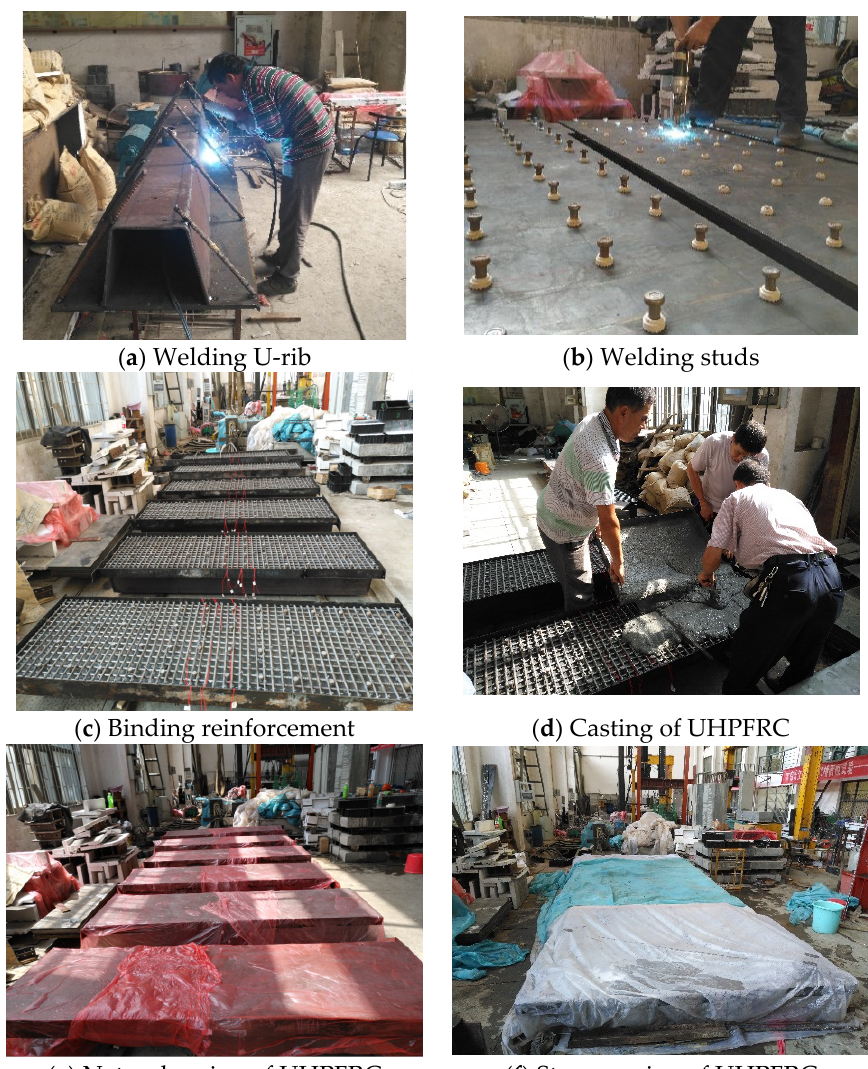
Figure 6. Main specimen preparation procedures.